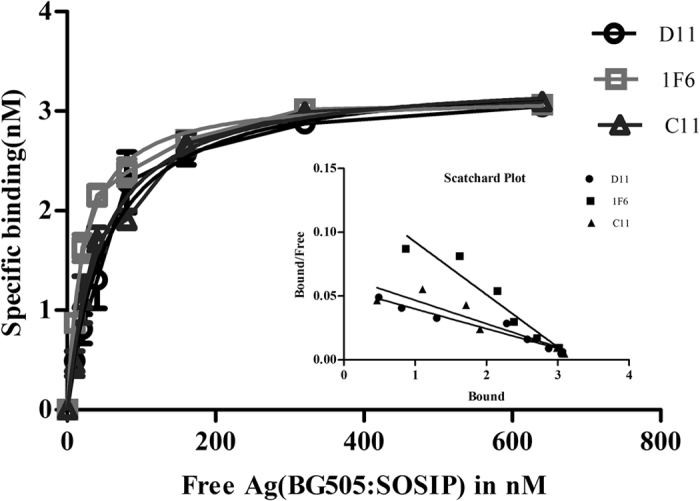
Dissociation constant (KD) of each of the 3 scFv-BG505:SOSIP.664 gp140 complex was determined by ELISA.Different dilutions of BG505:SOSIP.664 gp140 (10–640 nM) were incubated with fixed concentration of all the three scFvs (3.125 nM) and unbound antibody was detected by ELISA. The experiment was repeated at least twice. Saturation binding curve was plotted between free antigen Vs specific binding through non-linear regression analysis. KD values for C11 scFv is 4.581 ± 0.5613 × 10−8 M (R2 = 0.9776), for D11 scFv is 5.362 ± 0.8178 × 10−8 M (R2 = 0.9676), and for 1F6 scFv is 2.150 ± 0.1921 × 10−8 M (R2 = 0.9868).